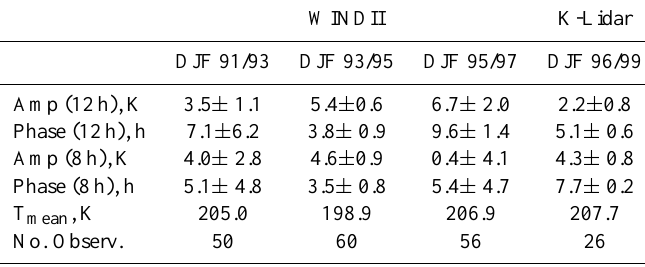
Table 1. Temperature tidal-fit parameters at 55 ◦ N and at 89km